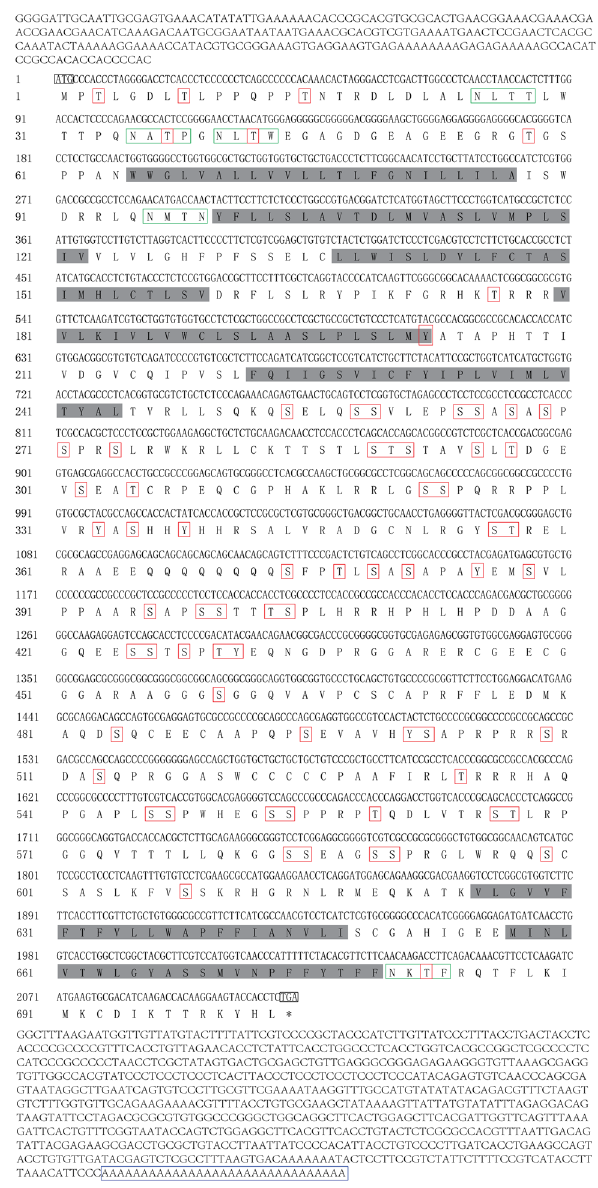
Figure 1. 5-HT2B receptor cDNA sequence for E. sinensis and its predicted amino acid sequence. The coding area was enumerated from the 236 bp end, and the base sequence is shown under the corresponding amino acid sequence. The start codon (ATG) and the stop codon (TGA) are highlighted by black lines. The red boxes delineate the putative phosphorylation sites, and the putative N-glycosylation sites are shown in green boxes. The shaded area shows the seven transmembrane regions. The blue box indicates the poly (A) tail. 5-HT2B receptor cDNA sequence for E. sinensis has been uploaded to NCBI, and the accession number of 5-HT2B is